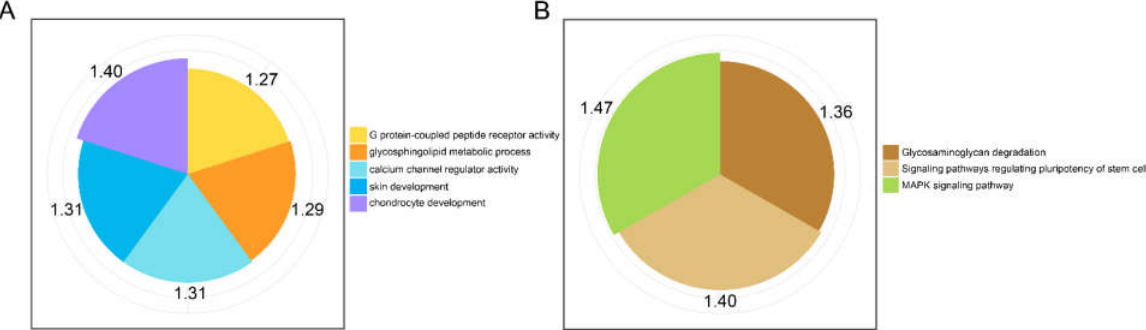
Figure 4. GO annotation and KEGG pathway analysis for candidate genes. ( A ), biological process of GO terms. ( B ), KEGG pathways. The numbers in the outermost layer indicated the − log 10 adjusted p -values.